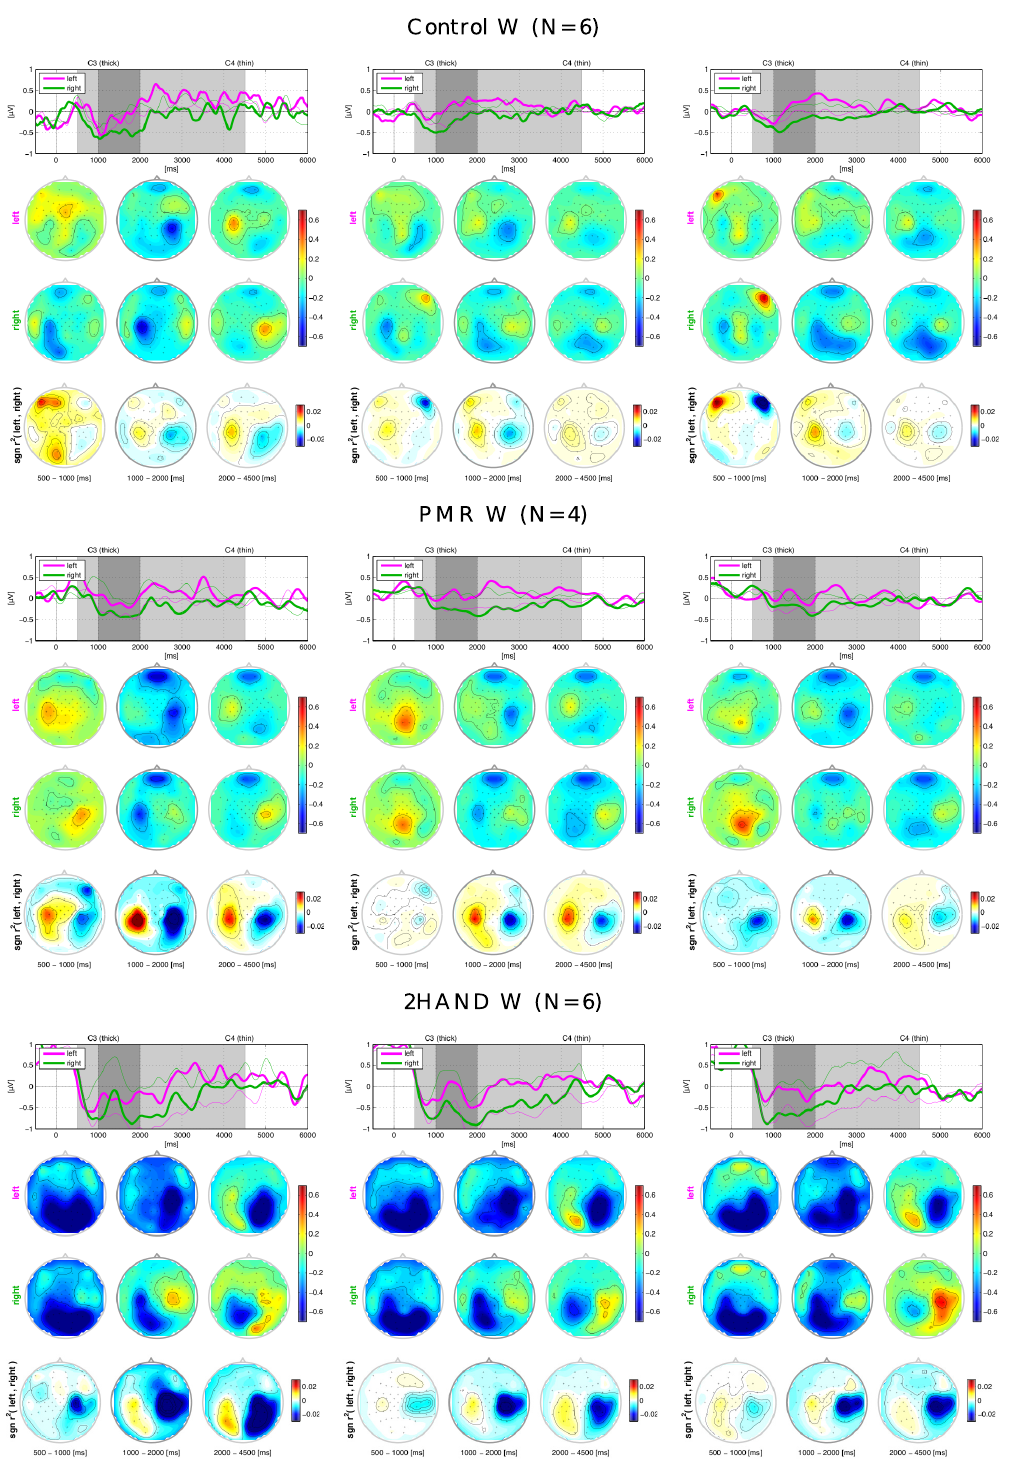
Fig 5. Grand average ERD/ERS for class combination left-right and intervention groups in Würzburg. ‘ N ’ is the number of participants of each group. From left to right: runs 1 – 3, runs 4 – 5, runs 6 – 7. The time plots in the first rows picture the evolution of the ERD/ERS for about 6000 ms at C3 (thick lines) and C4 (thin lines). At time 0 is the onset of the cue, at times 1000 – 4000 the display of the feedback. Magenta lines refer to left MI trials, green lines to right MI trials. The scalp plots underneath refer to the shaded areas of the time plots and show the distribution of the ERD/ERS. In the second rows, the scalp plots of the left MI trials, in the third rows the scalp plots of the right MI trials and in the fourth the scalp plots of the sign-r 2 .